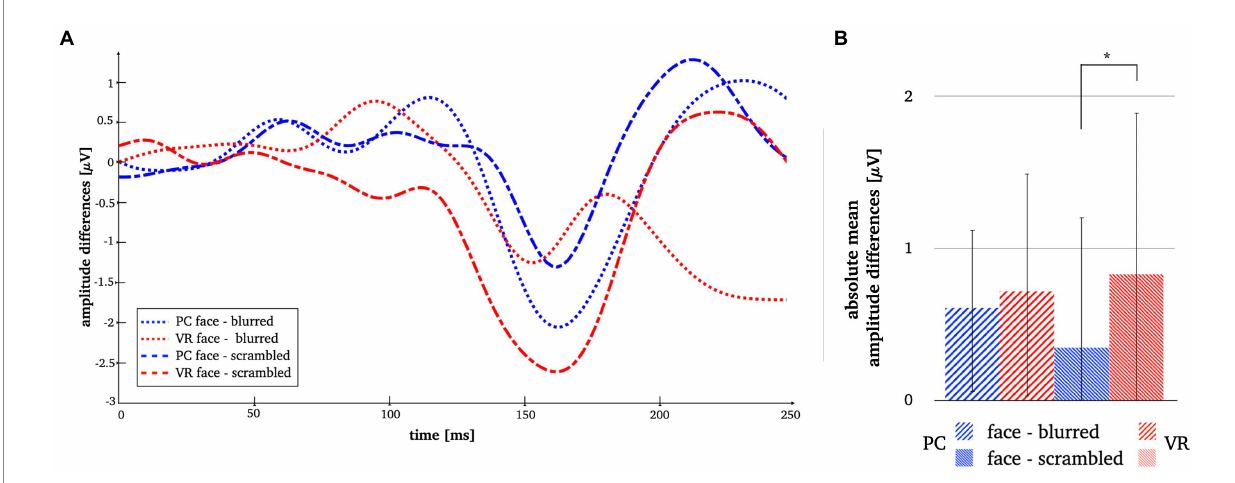
FIGURE 9 Panel A illustrates the N170 amplitude differences after subtraction of the perceptual controls in both modalities. Panel B depicts the absolute mean face amplitudes after subtraction of the perceptual controls in both modalities. The error bars depict the confidence intervals for the mean values. Significant differences are marked (* p < 0.05).